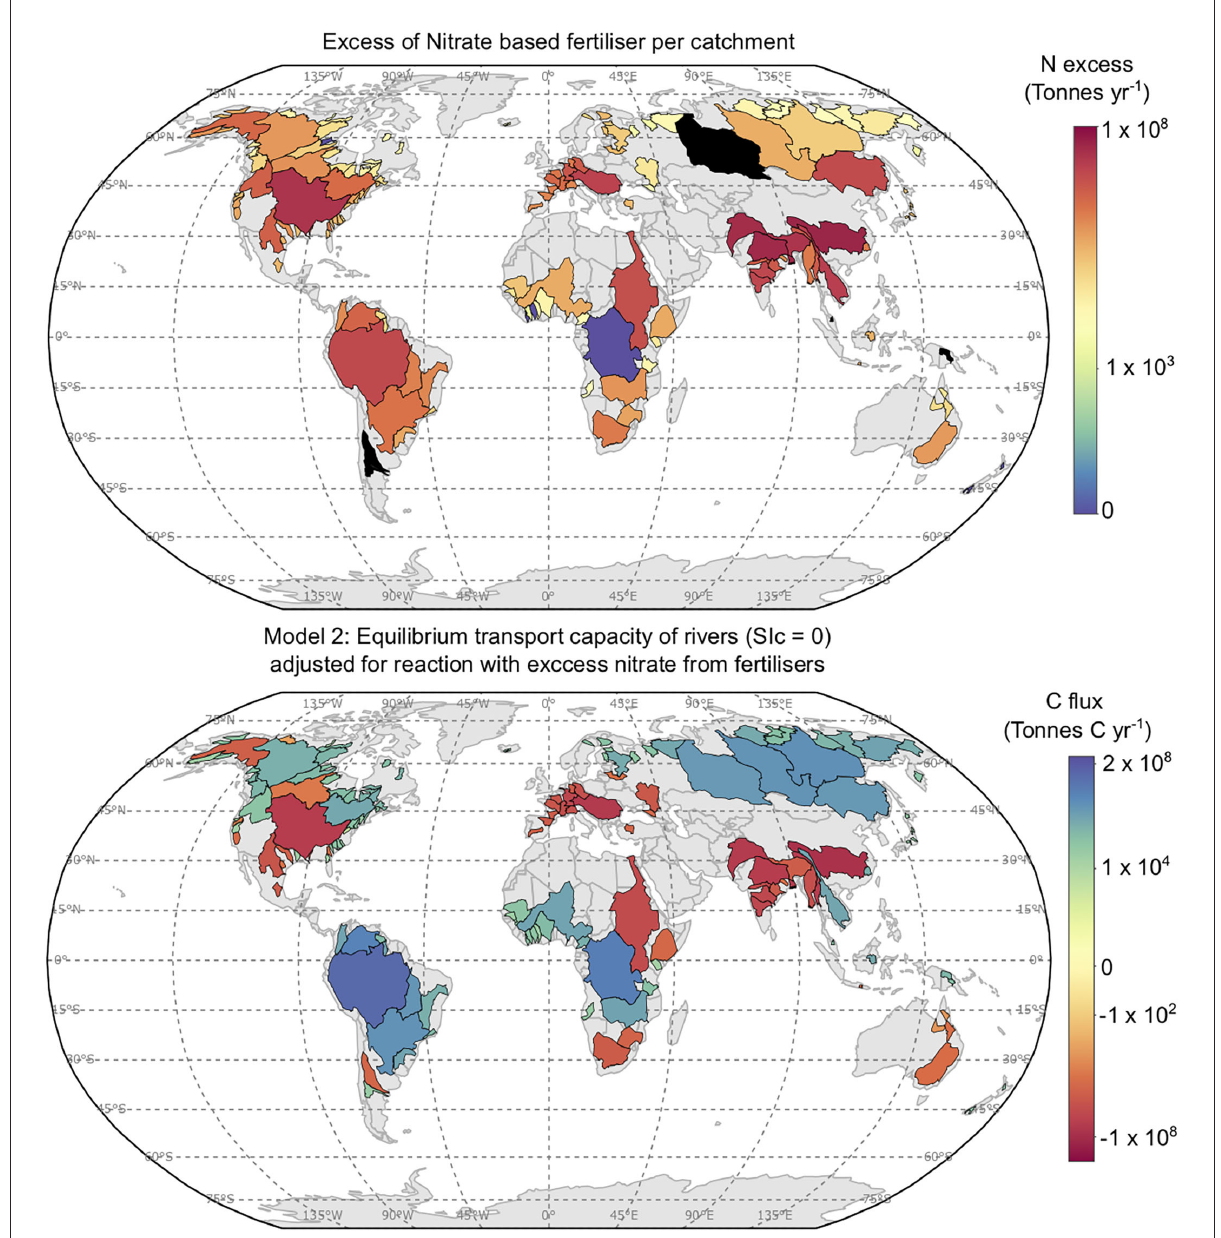
FIGURE9 Top: Excess nitrogen based fertiliser per catchment studied (Tonnes yr − 1 ). Nitrogen excess data from Lassaletta et al. (2014), and the mass of nitrogen used is available from: https://www.fao.org/faostat/en/?dat. Black catchments occur for areas where nitrogen mining occurs, which skews estimates of nitrogen use efficiency. Bottom: PTCC values (Tonnes C yr − 1 ) for Model 2, recalculated assuming 15 % of excess nitrate in each catchment reacts with agricultural lime applied to aribal